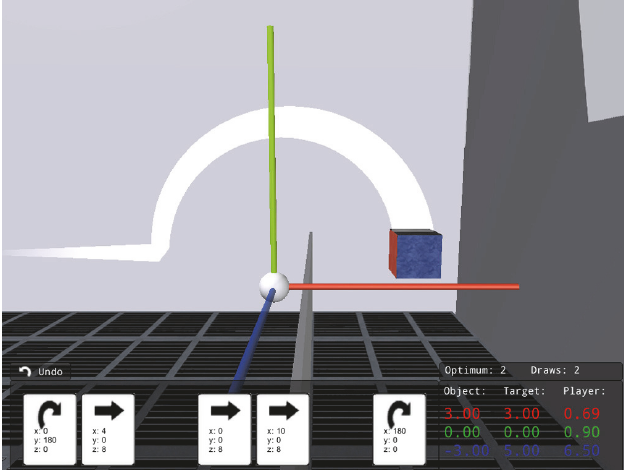
Figure 2: GEtiT used a very rudimentary visual presentation in its prototype version. This version also lacks a color-coding for the different AT operation types and an acoustic feedback when playing an AT card.